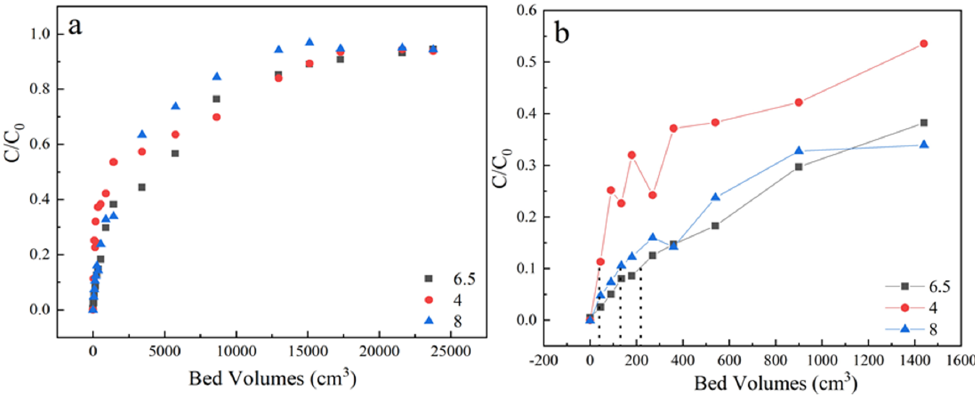
Figure 5. ( a ) The adsorption e ff ect of di ff erent pH on breakthrough curves, ( b ) Partially enlarged screening from 0 to 1600 bed volume. Experiment condition: flow rate of 3 mL / min, column height of 3 cm, sulfamethoxazole concentration of 35 mg / L, pH 4, 6.5, 8